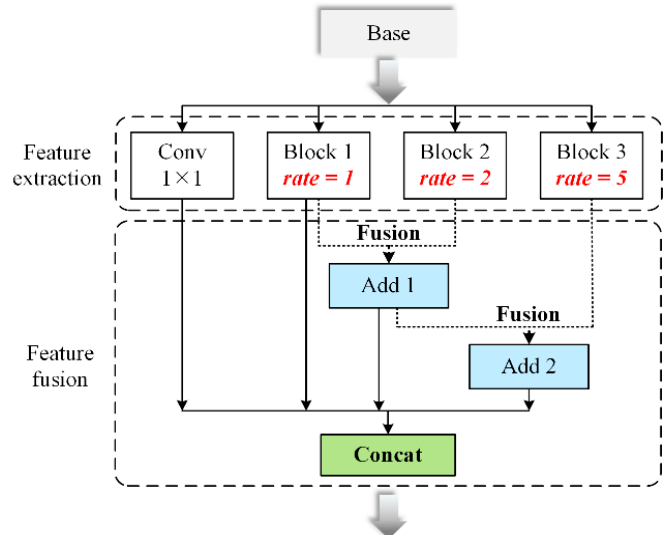
Figure 3. Illustration of the designed Siamese architectures for change detection. Hybrid convolutional feature extraction module (HCFEM), including: (1) Feature extraction unit. (2) Feature fusion